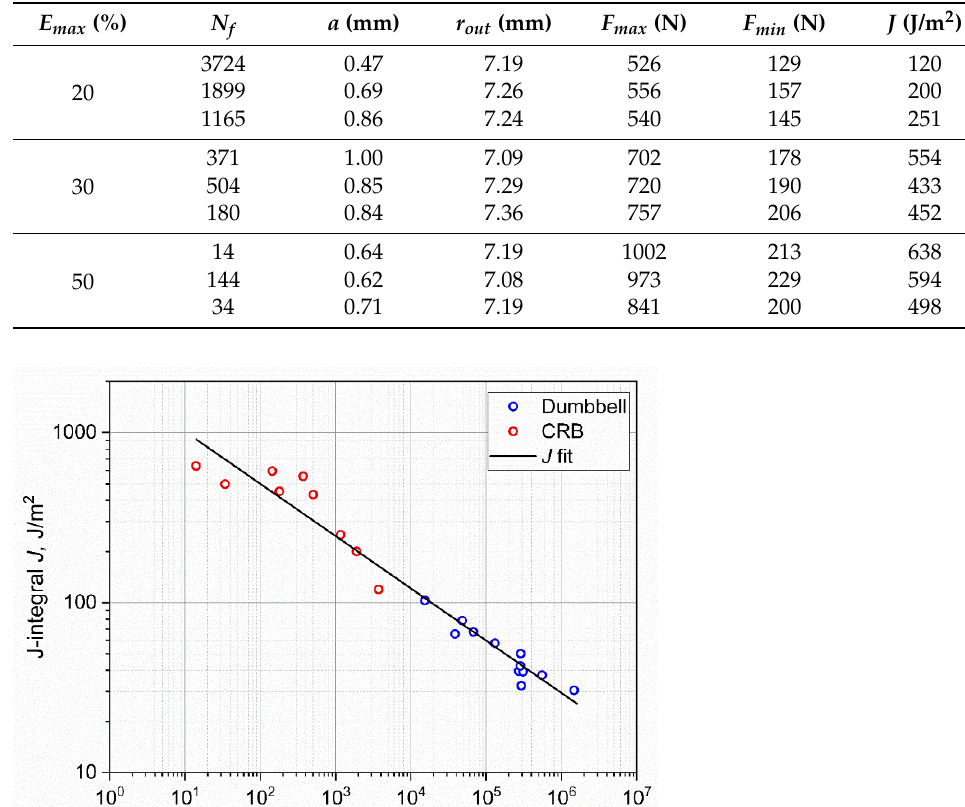
Table 3. Overview of the values used to calculate the J-integrals for CRB using Equation (13).